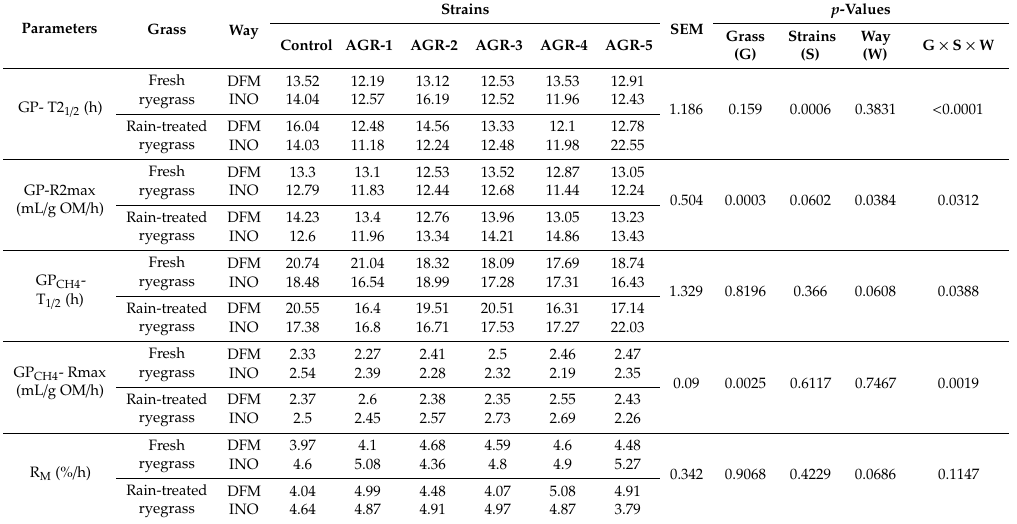
Table 4. E ff ect of LAB strains on fermentation characteristic.